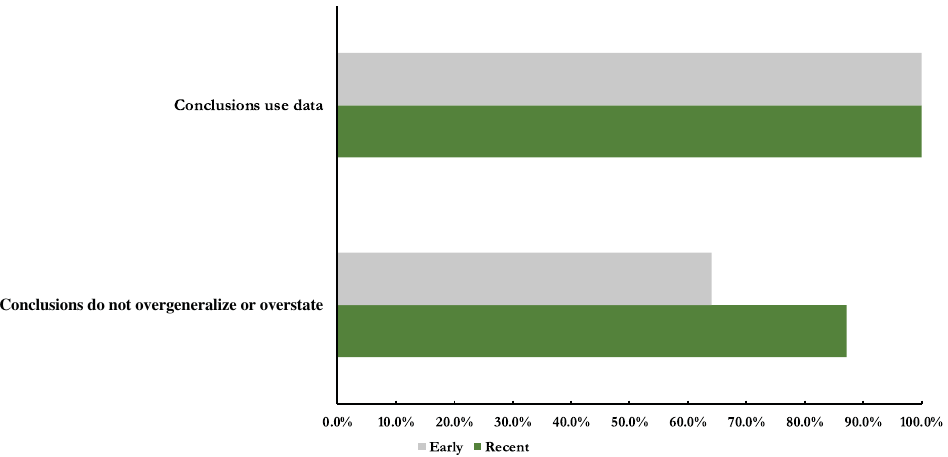
Conclusions do not overgeneralize or overstate